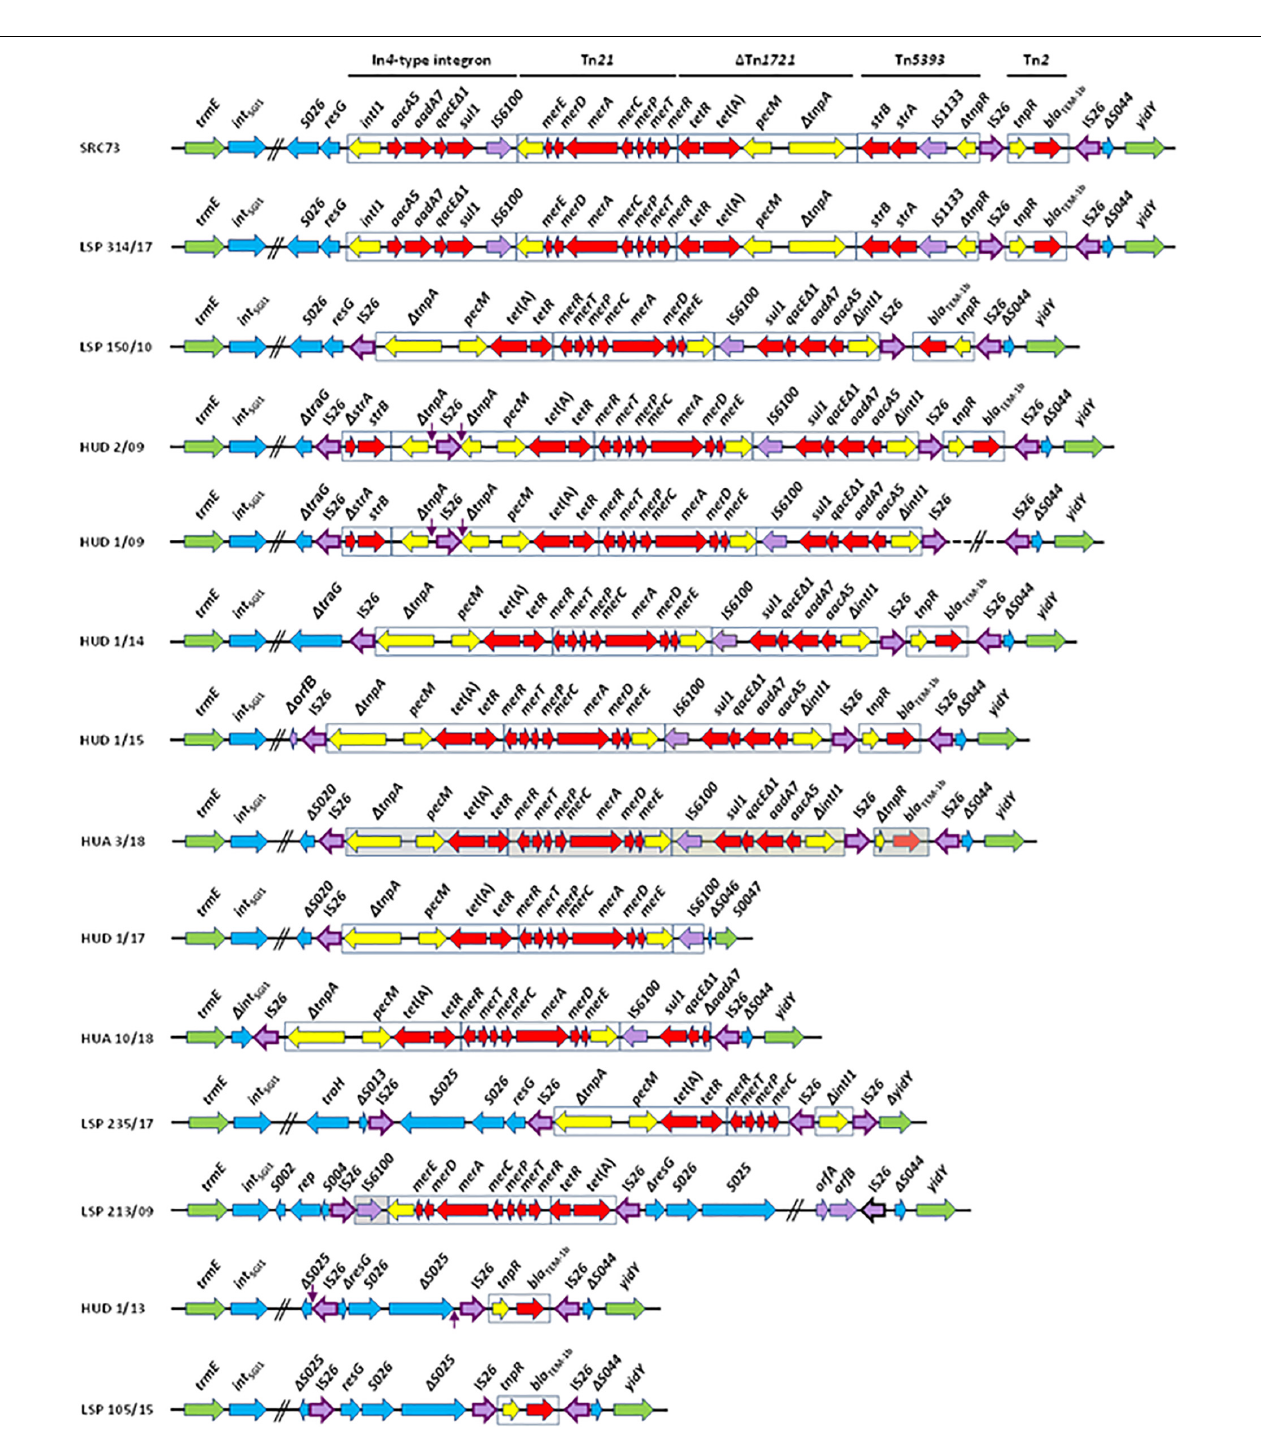
FIGURE 1 | SGI1-K (SGI1-P) variation in Salmonella enterica serovar Kentucky ST198-Cip R from Spanish hospitals. Coding regions are represented by arrows pointing in the direction of transcription and having different colors according to their function. Green, flanking chromosomal DNA; blue, SGI1 backbone; red, resistance genes; yellow, transposon and integron genes other than resistance genes; purple, insertion sequences with IS 26 highlighted by a darker border. Target site duplications are indicated by vertical arrows. Contiguous horizontal lines crossed by two parallel oblique lines indicate that not all genes are shown. In HUD 1/09, the dashed line crossed by two parallel oblique lines denotes that the corresponding sequence is unknown. LSP, Laboratory of Public Health of the Principality of Asturias, acting as regional reference center for Salmonella . LSP isolates come from “Hospital Universitario Central de Asturias,” Oviedo, Asturias (LSP 213/09 and LSP 105/15), “Hospital Universitario de Cabueñes,” Gijón, Asturias (LSP 150/10 and LSP 314/17) and “Hospital Universitario San Agustín,” Avilés, Asturias (LSP 235/17). HUD, “Hospital Universitario Donostia,” Basque Country; HUA, “Hospital Universitario de Álava,” Basque Country.